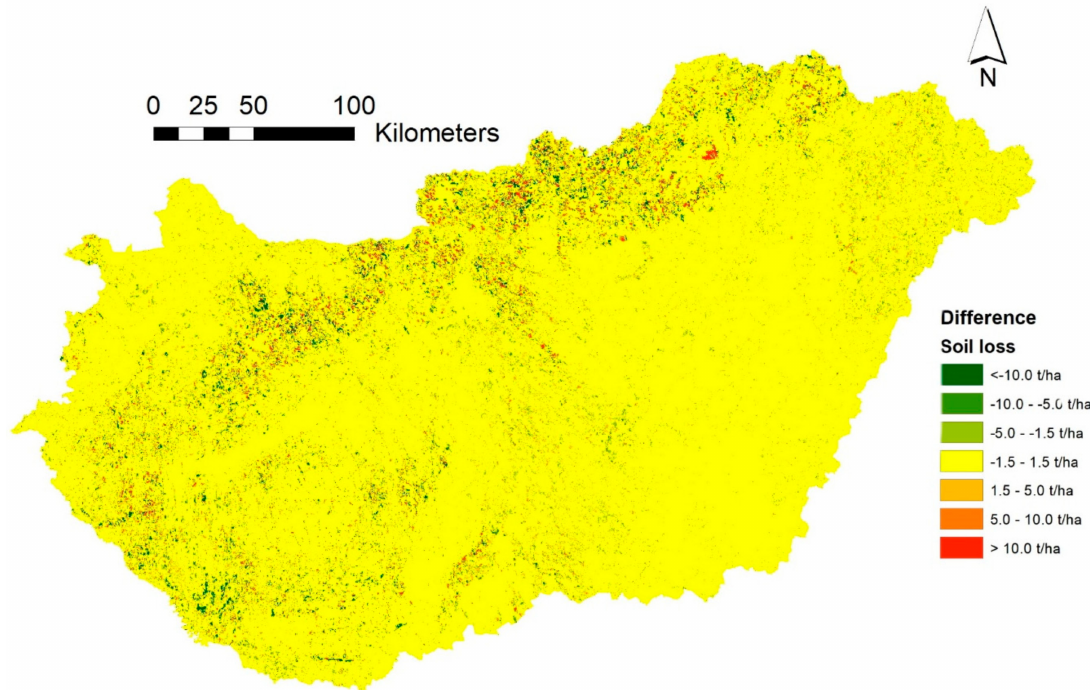
Figure 9. Change in erosion estimates from 1990 to 2018 LULC (PESERA and USLE models